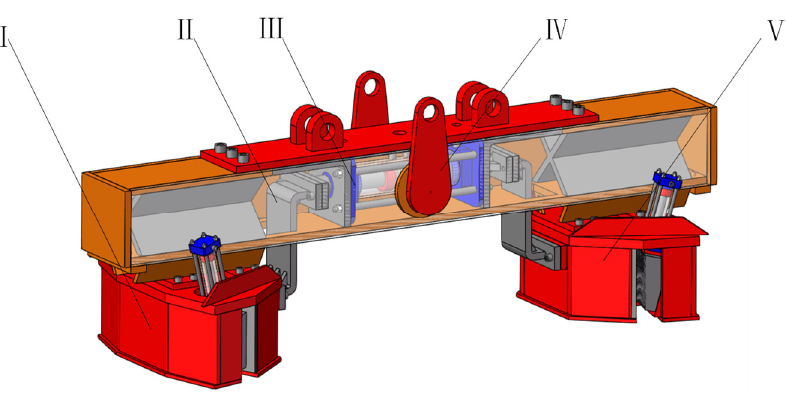
Figure 16. Overall Structure of Internal and External Clamping Type Marine Pile Spreader with Changeable Diameter.